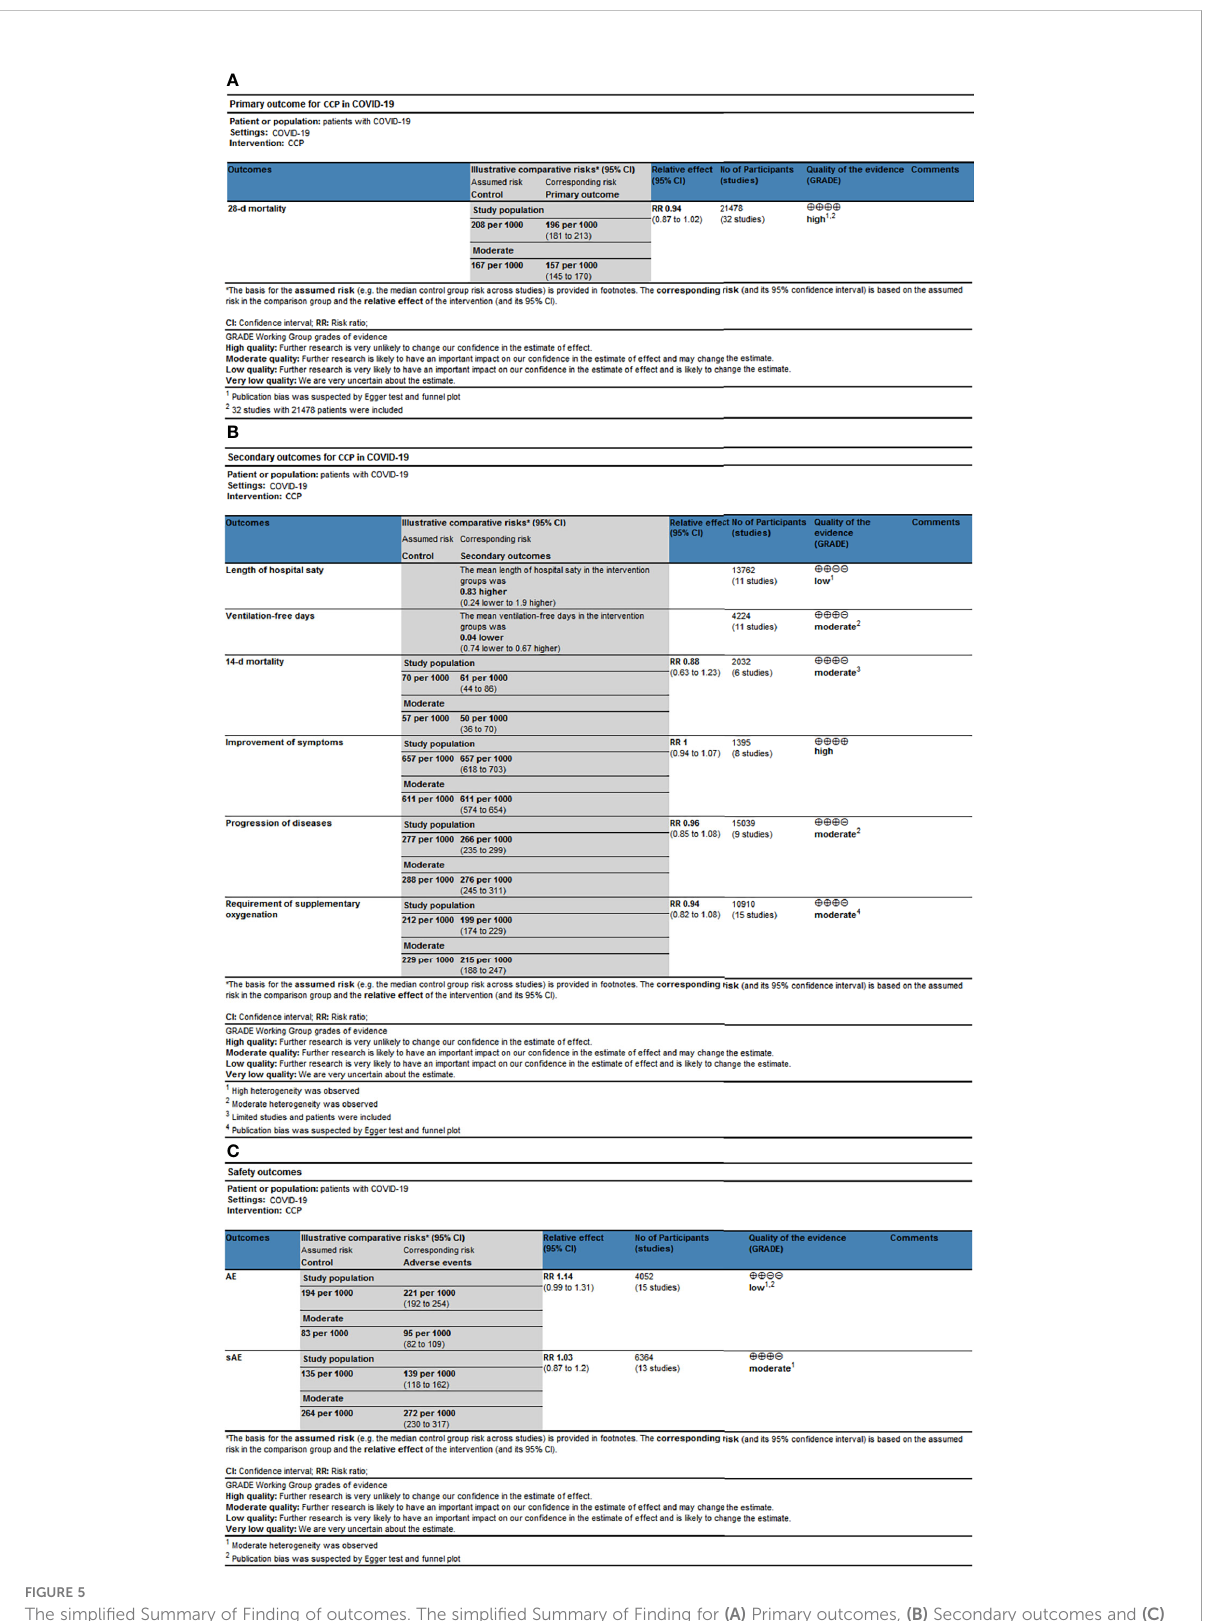
FIGURE 5 The simpli fi ed Summary of Finding of outcomes. The simpli fi ed Summary of Finding for (A) Primary outcomes, (B) Secondary outcomes and (C) Safety outcomes. CCP, COVID-19 convalescent plasma; 95% CI, 95% con fi dence interval; RR, risk